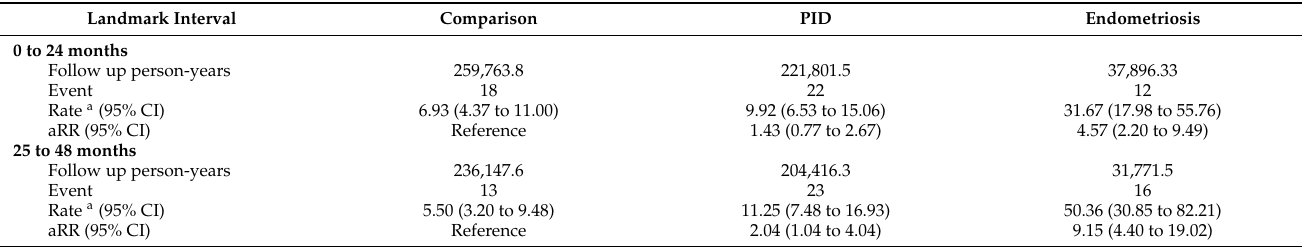
Table 4. Landmark analysis for time varying effect on the risk of uterine corpus